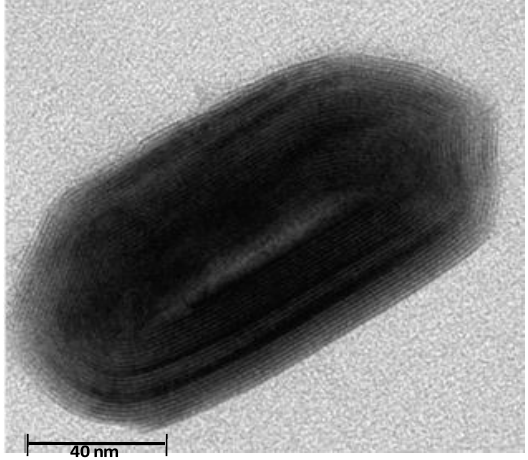
Figure 7. TEM micrograph of a hollow ellipsoidal IF-WS